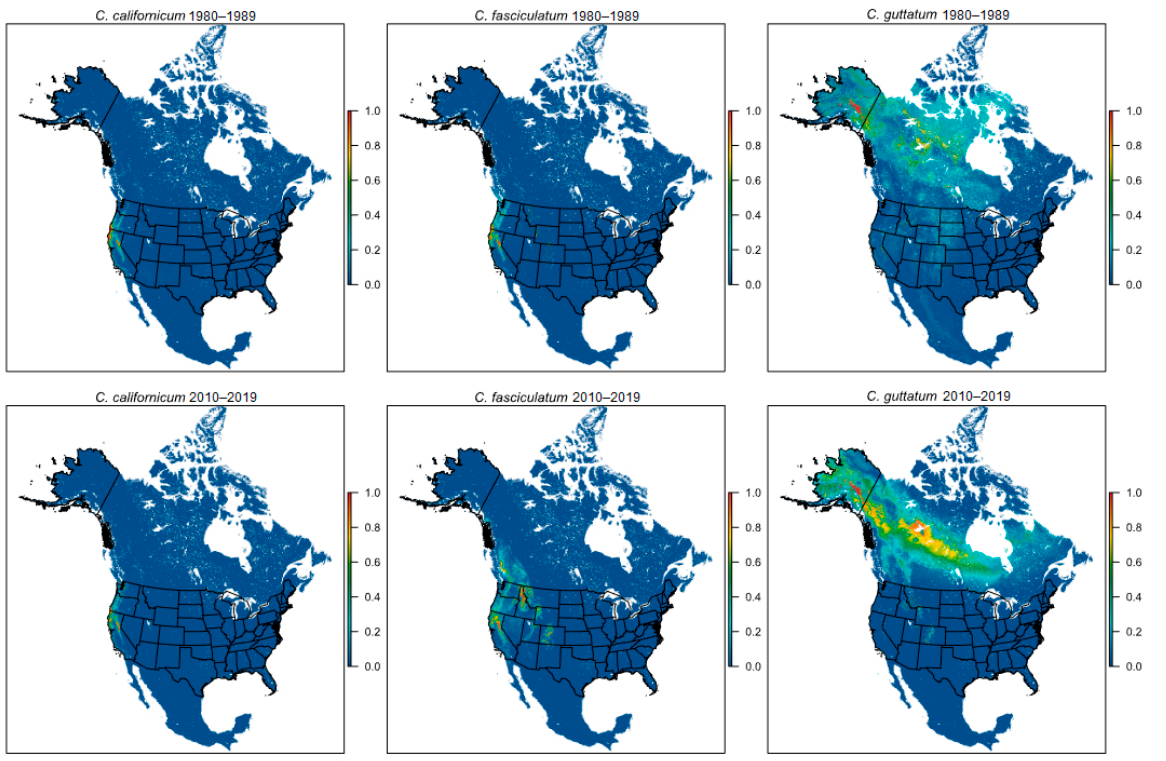
Figure 2. Maps showing M AXENT cloglog predictions of suitable habitat for the three western spe- cies: C. californicum , C. fasciculatum , and C. guttatum . The top row illustrates the ETI prediction and the bottom row shows the LTI model. Colors illustrate suitability of habitat, with red indicating optimal habitat and dark blue indicating the least suitable habitat.